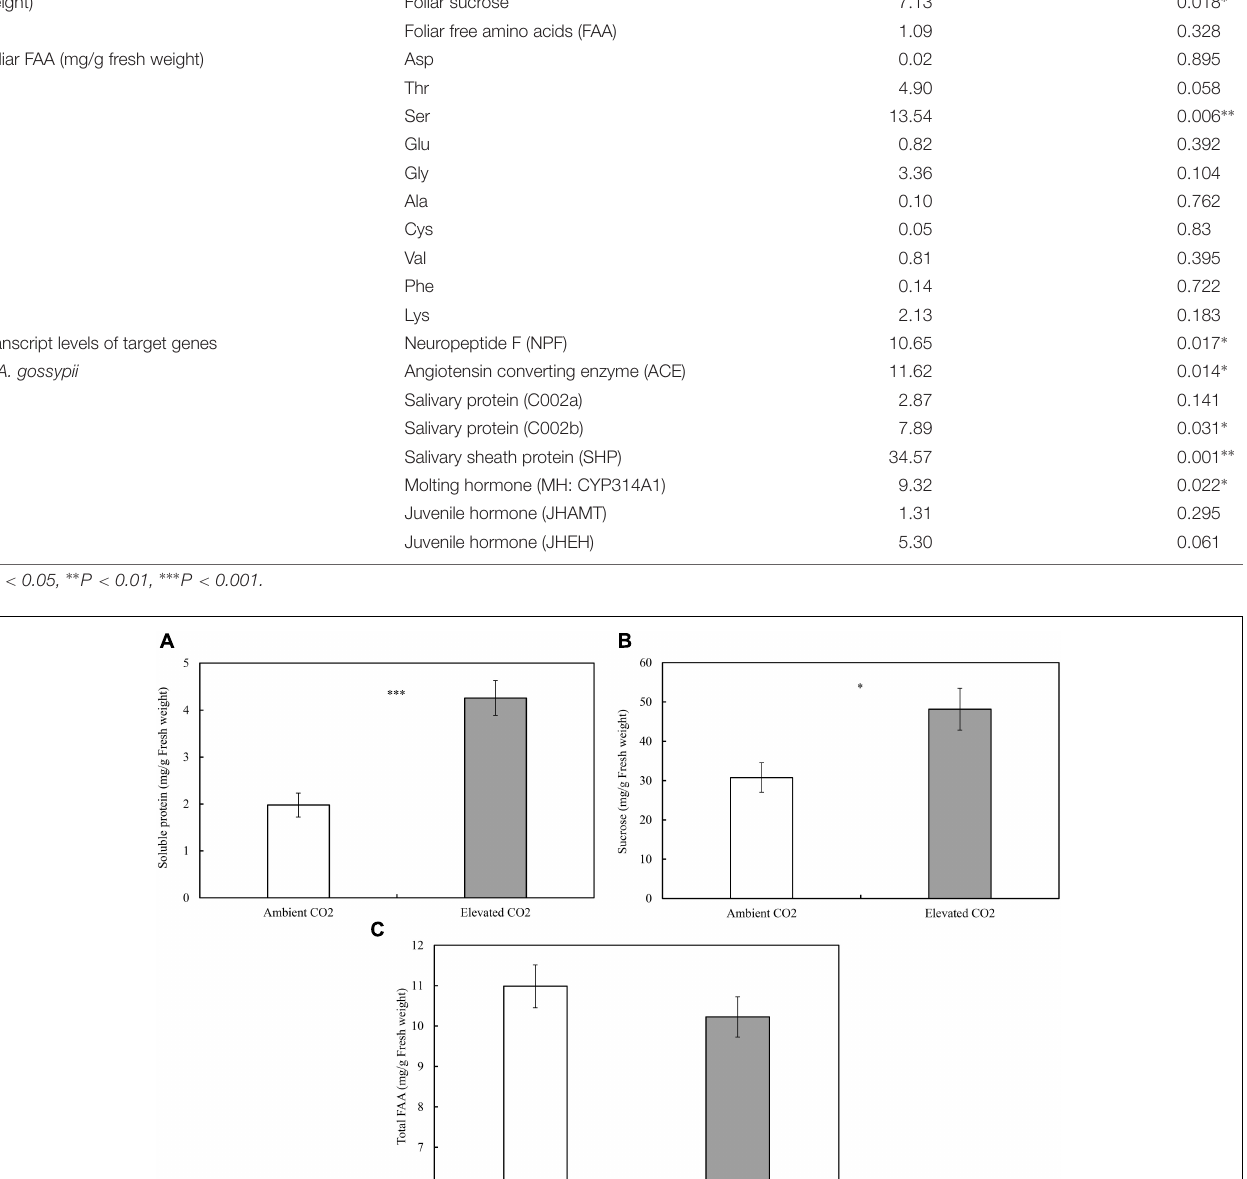
the development duration of the third instar nymph ( F =